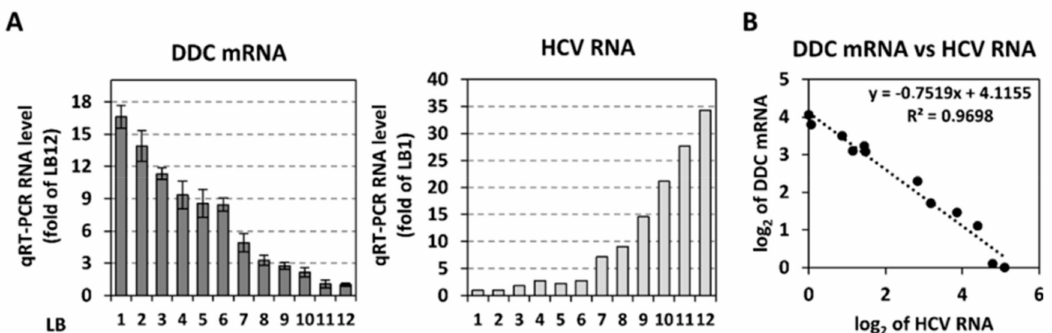
Figure 8. Inverse correlation between HCV RNA and DDC gene expression levels in human liver biopsies. ( A ) Total RNA was isolated from 12 liver samples (LB 1 to 12) from patients with chronic hepatitis C previously characterized for their HCV RNA amounts (right) with the branched DNA assay (Figure adapted from Vassilaki et al. 2013 [68], Copyright © American Society for Microbiology). The DDC mRNA in these samples was quantified by RT-qPCR (left). YWHAZ mRNA levels were used for normalization. Values are expressed relative to those obtained with sample LB 12. Bars represent mean values of DDC RNA copies from three technical replicates, and error bars indicate standard deviations. ( B ) XY scatter plot and linear regression analysis of log 2-transformed relative levels of DDC mRNA versus HCV genome. R 2 indicates coe ffi cient of